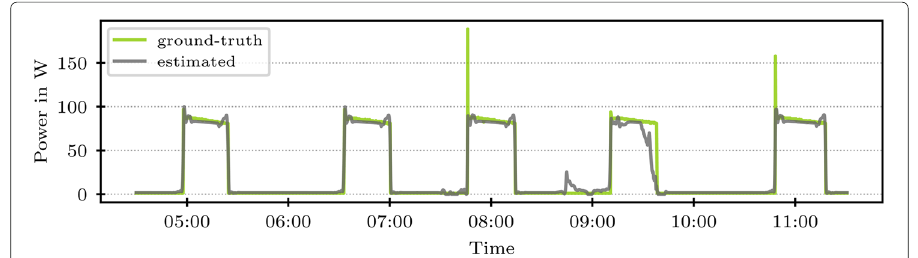
Fig. 11 An excerpt of estimates provided by S2P for the fridge in REFIT house 2 when applied to the denoised